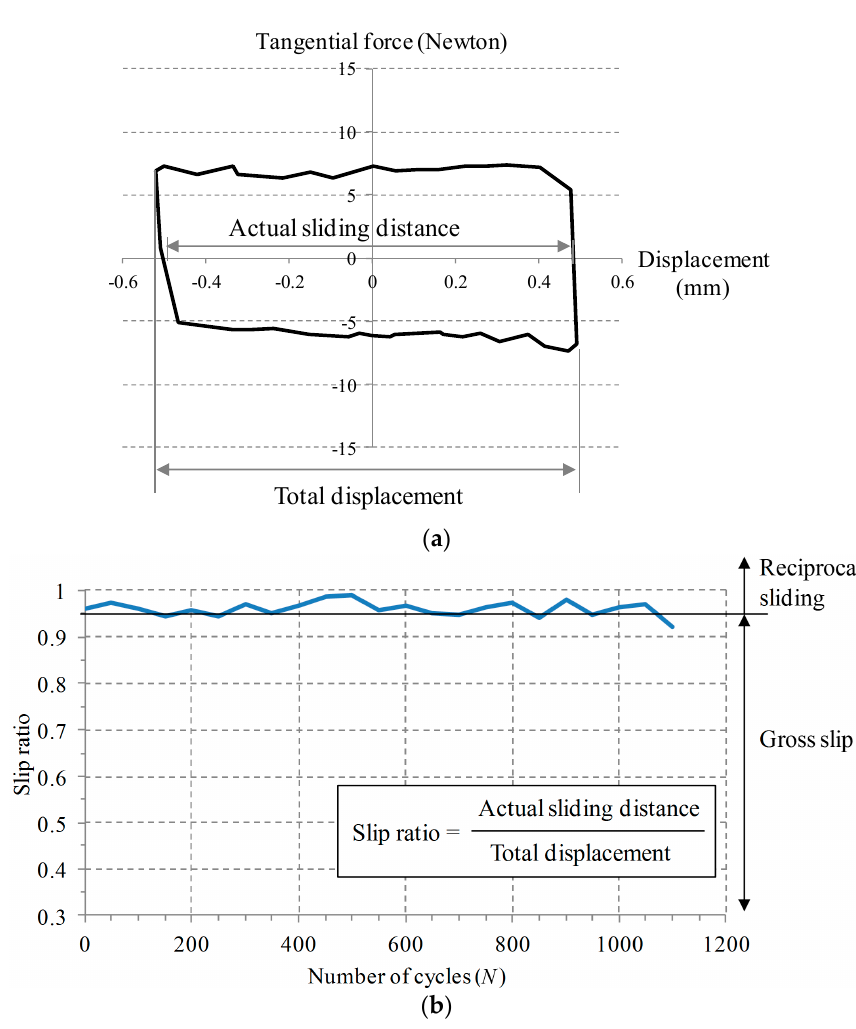
Figure 3. Tangential force versus displacement loop ( a ) and slip ratio ( b ) at a normal force of 25 N, a displacement of 1 mm, and a frequency of 1 Hz.